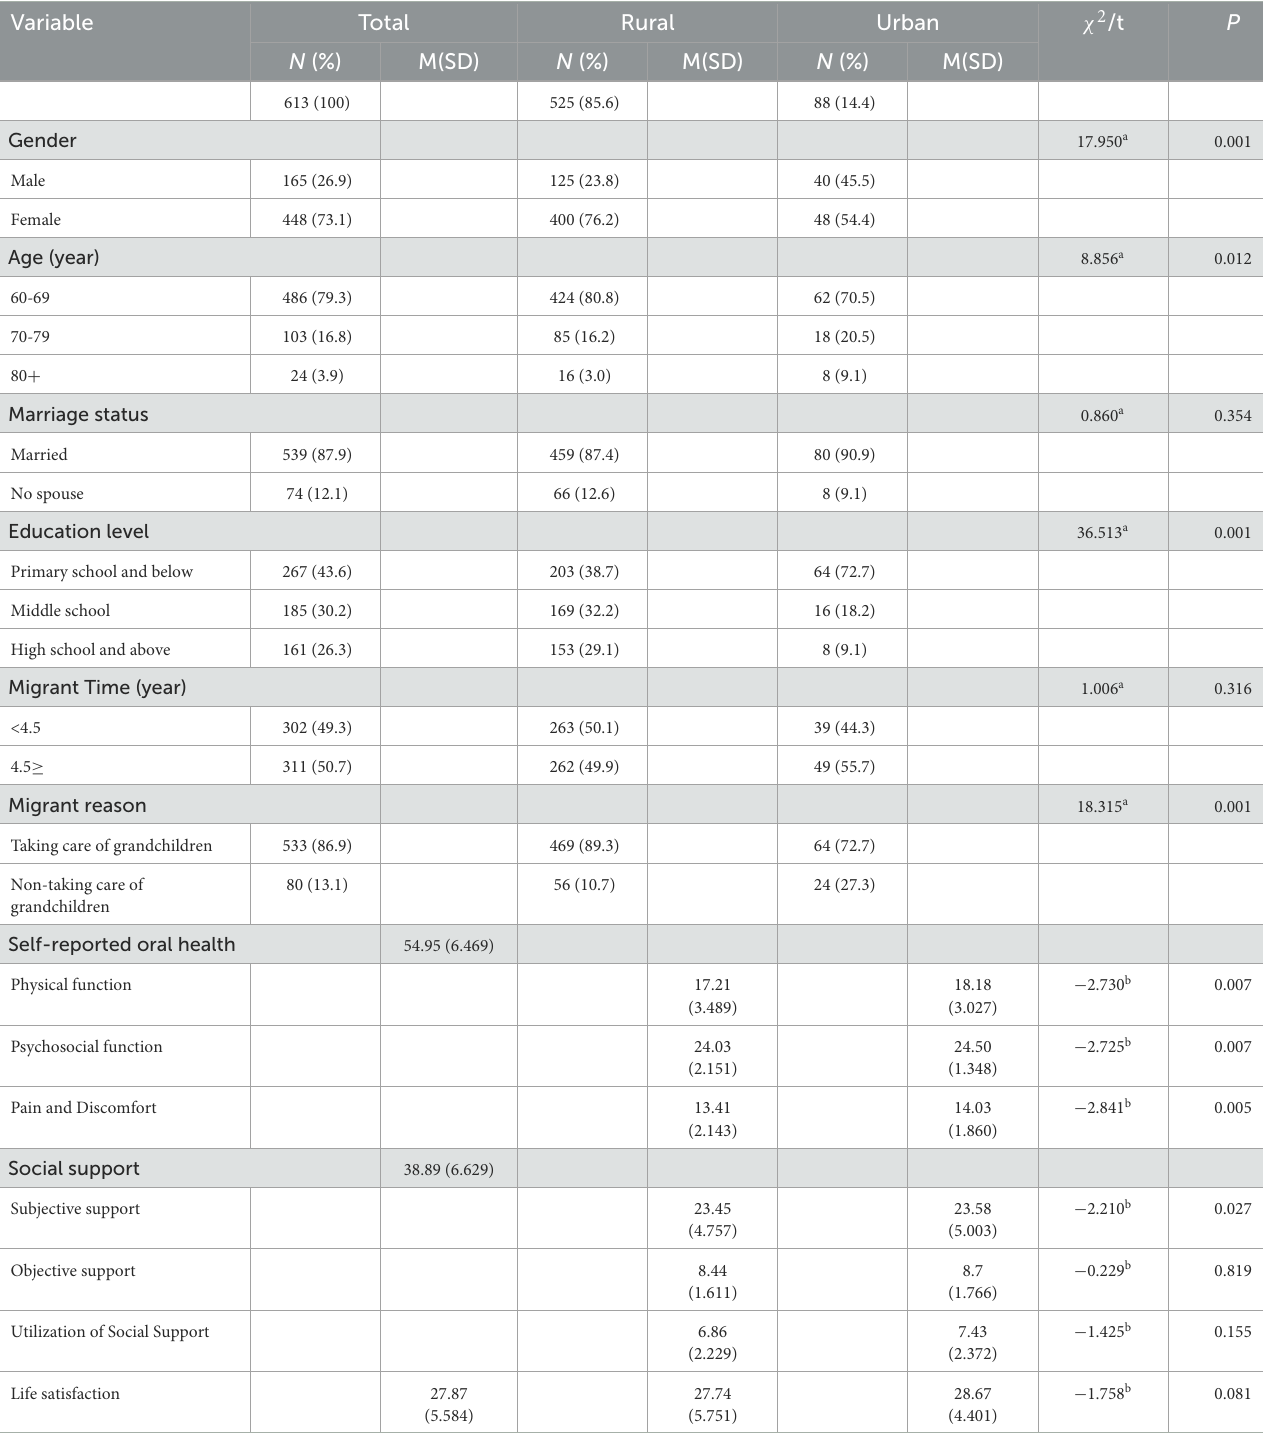
TABLE 1 Sociodemographic characteristics and urban-rural differences in sociodemographic characteristics, self-reported oral health, social support, and life satisfaction.